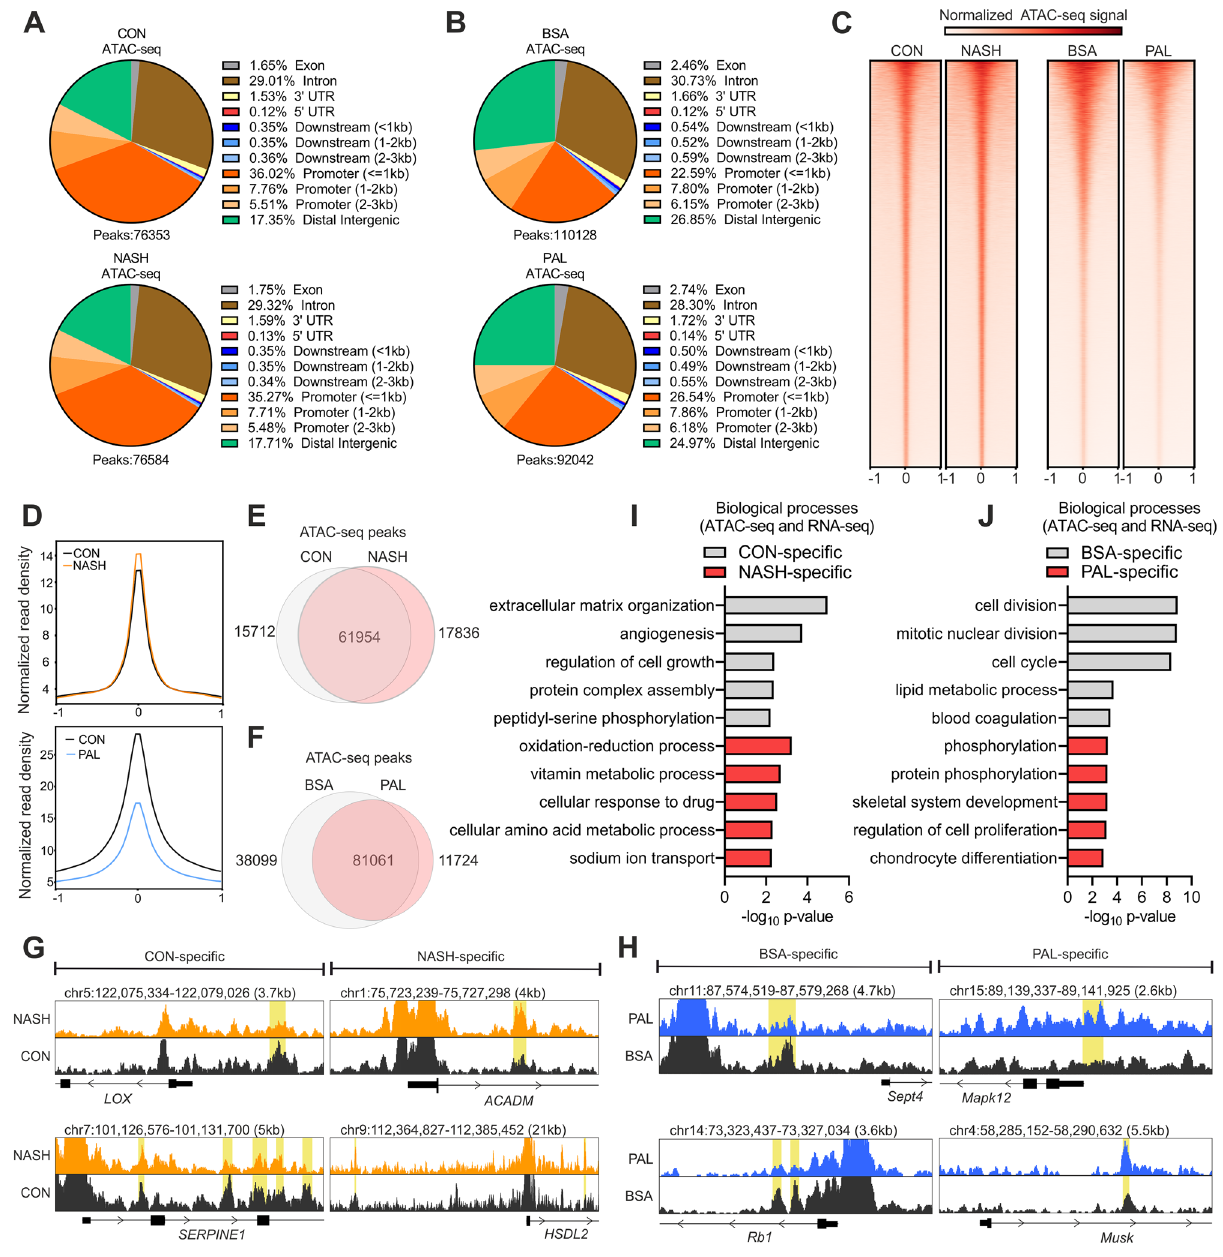
Figure 3. Chromatin accessibility is altered by NASH and lipotoxicity. ( A , B ) Annotation of ATAC-seq peaks in ( A ) human liver (n = 4 per group) and ( B ) mouse hepatocytes (n = 3 per group). ( C ) Heat maps of ATAC-seq peaks aligned to their centre ± 1 kb. ( D ) Density plots showing averaged normalized signal of ATAC-seq peaks aligned to their centre ± 1 kb. ( E , F ) Overlap of ATAC-seq peaks between ( E ) CON and NASH liver or ( F ) BSA and PAL hepatocytes. ( G , H ) Genome browser views of representative ( G ) CON- or NASH-specific peaks in human liver and ( H ) BSA- or PAL-specific peaks in mouse hepatocytes (marked yellow). ( I , J ) Gene ontology analysis showing biological processes regulated by genes linked to ( I ) CON- or NASH-specific peak in human liver and ( J ) BSA- or PAL-specific peaks in mouse networks (Figs. 4G,H, S1A and S1B; distal intergenic: 5 and promoters: 4). Indeed, a number of transcription factors with known function in the regulation of liver function and NAFLD development were members of PPI networks at distal intergenic regions and promoters, including HNF4A, SMADs, ATF3, RXRA and ARNTL (Figs. 4G,H, S1A and S1B) 11–14 . To refine the identification of relevant transcription factor candidates in an unbiased manner, we performed transcription factor motif enrichment analysis with each of the independent datasets generated from human liver and mouse hepatocytes (Table S4). The overlap between these datasets uncovered 227 motifs representing 170 transcription factors commonly enriched both in human liver and mouse hepatocytes (Fig. 5A). We next used our transcriptomic data to perform Integrated System for Motif Activity Response Analysis (ISMARA), which